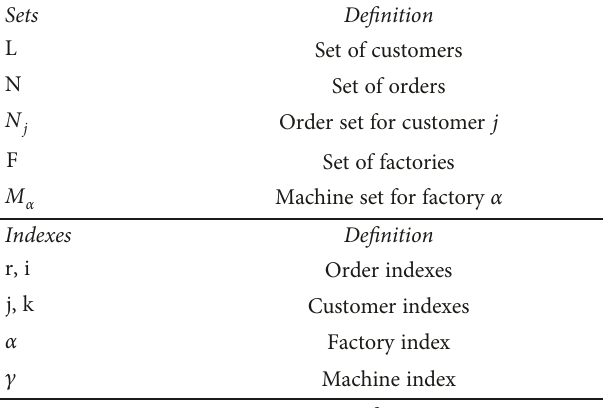
Table 1: De fi nition of sets, indexes, parameters, and